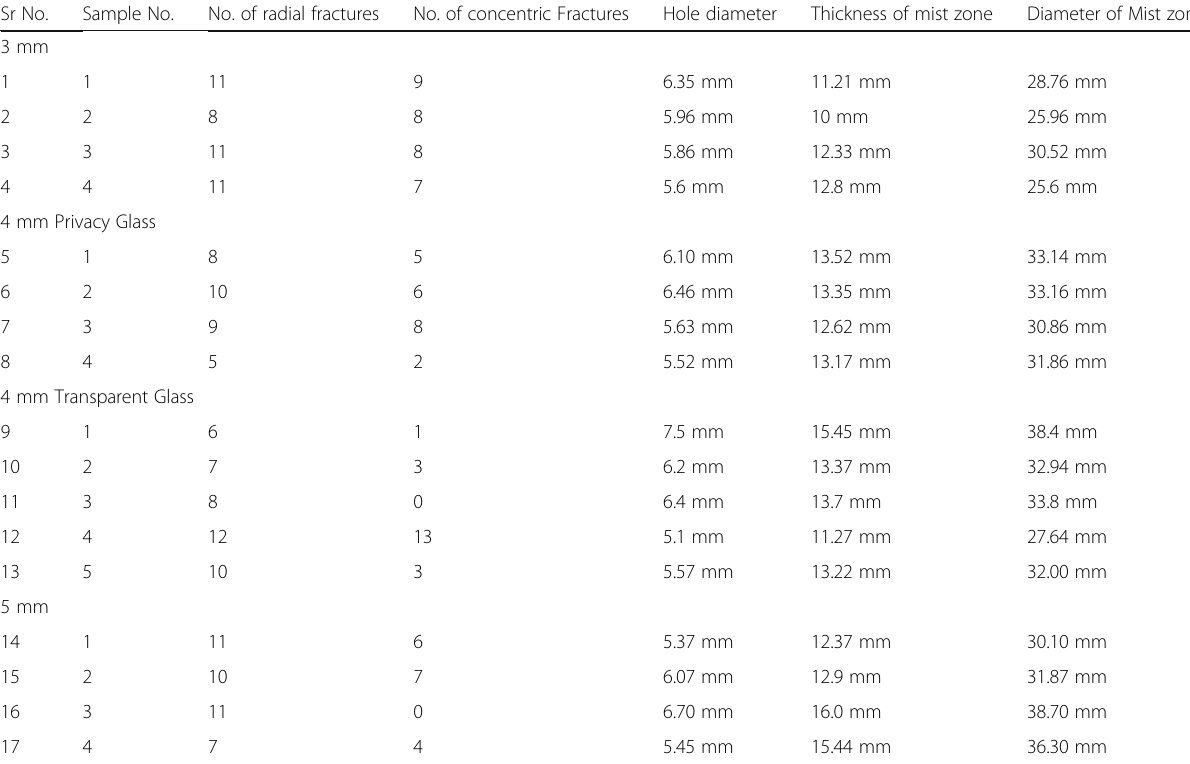
Table 2 Measurements for the Glass panes without coating of the Sun Control Film Sr No. Sample No.